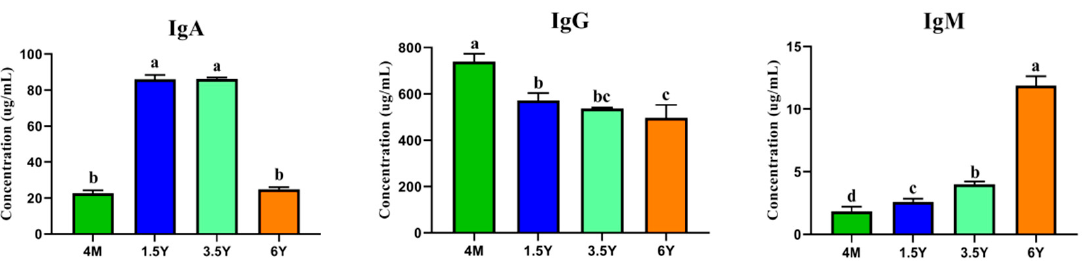
Figure 1. Serum immune indices at different ages. Note: Different lowercase letters above the column indicate significant differences, p < 0.05. 4M: 4 months; 1.5Y: 1.5 years; 3.5Y: 3.5 years; 6Y: 6 years.